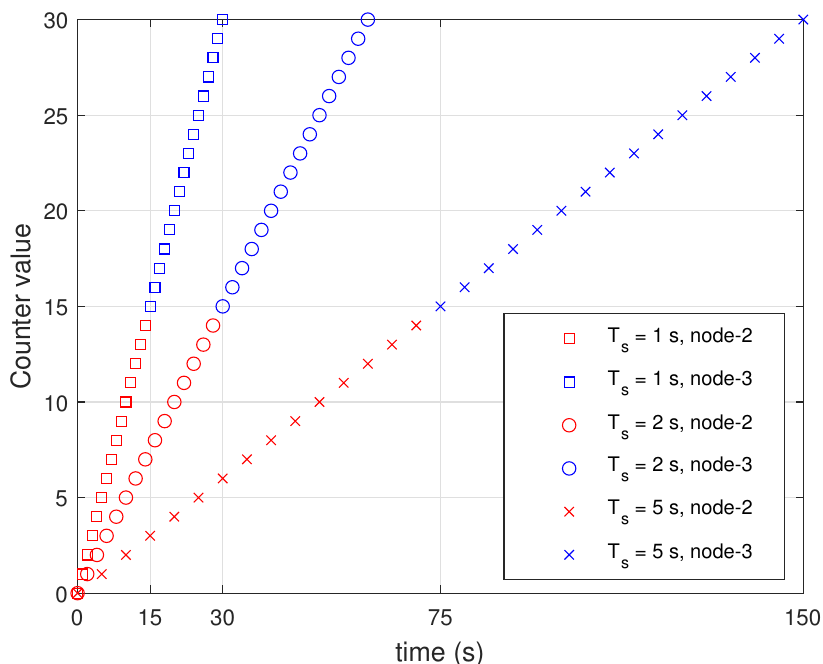
Figure 8. Performance of switching algorithm in WSAN testbed experiments.